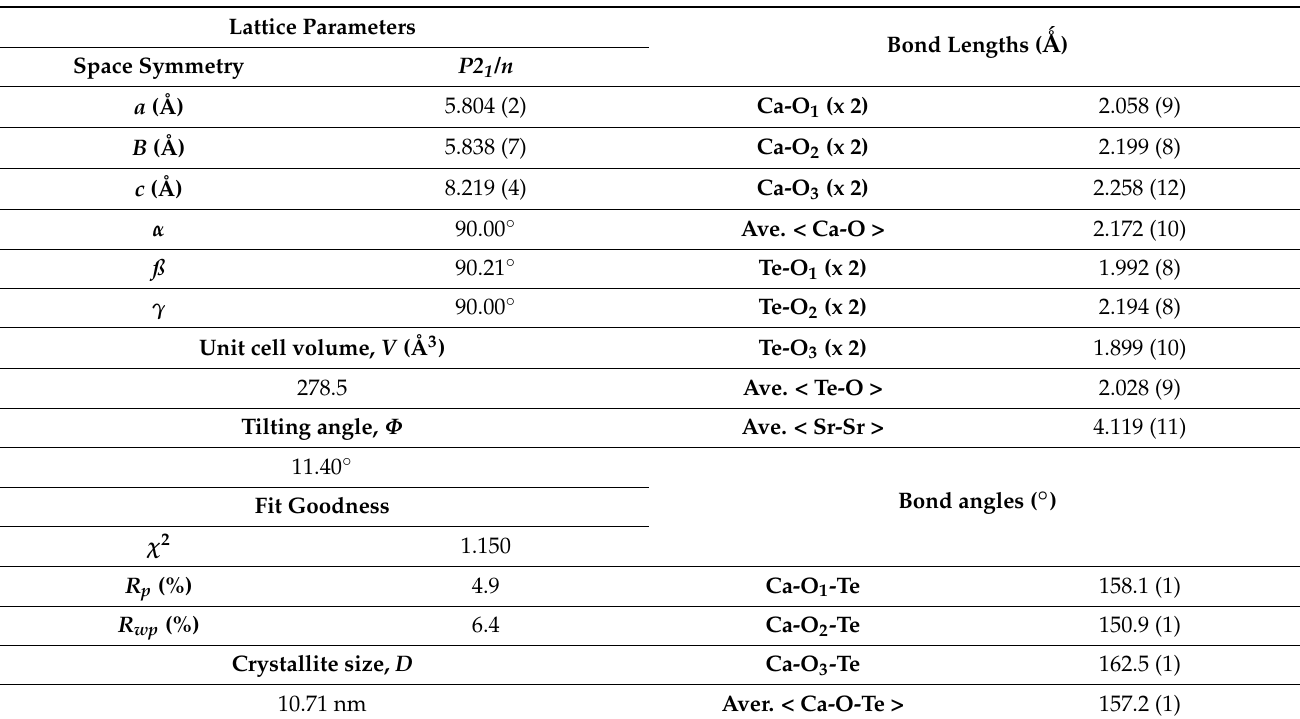
Table 1. Obtained space symmetry, parameters of lattice, V , angles of bonds, lengths of bond, and fit goodness from Rietveld refinement with calculated ϕ , τ , and D in Sr 2 CaTeO 6 .